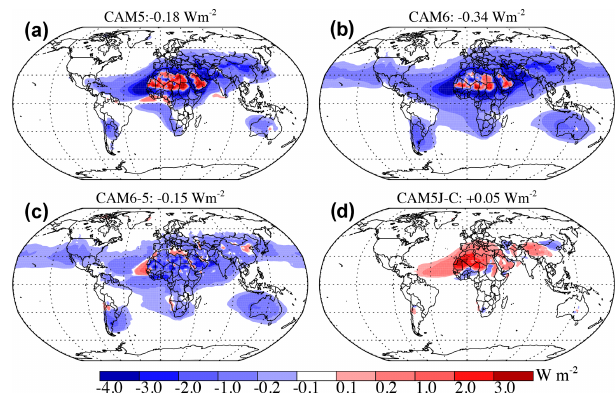
Figure 7. Shortwave TOA DRE (Wm − 2 ) in CAM5 (a) and CAM6 (b) with C1999 (a, b, c) and J2014 (d) and their differ- ences (c, d) for 2007–2011. DRE in CAM6 was remapped onto CAM5 grids. Numbers in the title show global mean DRE (a, b) or difference: between CAM6 and CAM5 (c) ; between CAM5 with J2014 and with C1999 (d)